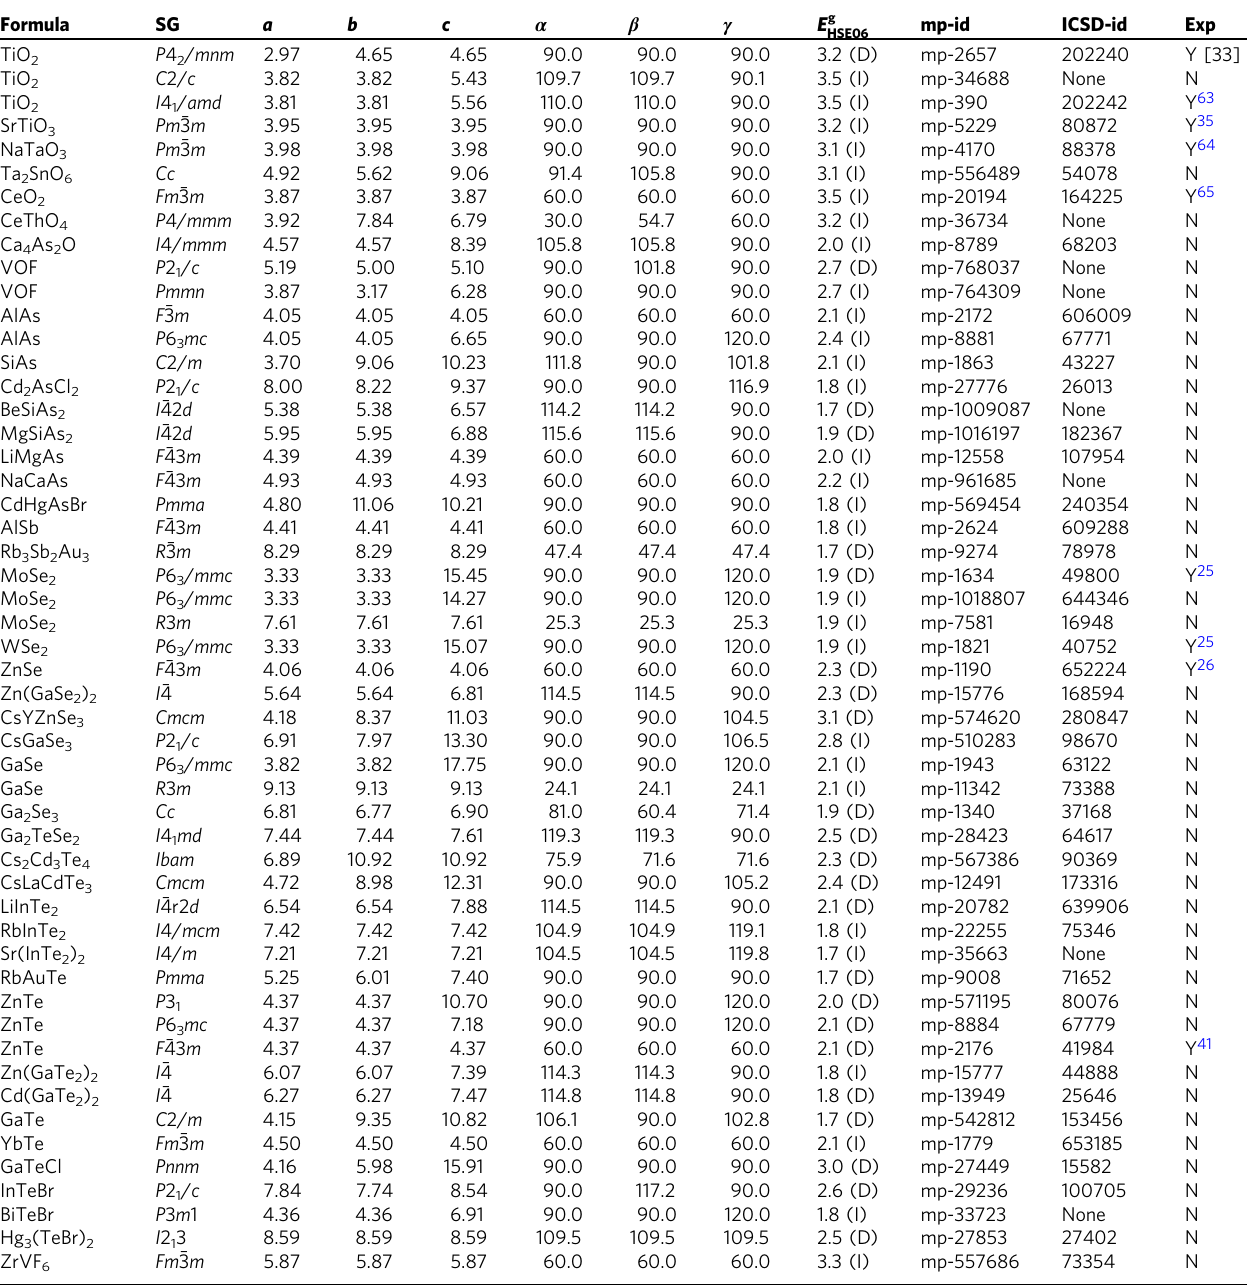
Table 1 The spacegroup (SG), the lattice constants ( a , b , c in Å, α , β , γ in °), bandgaps computed with HSE06 functional ( E g eV), the MP material-id (mp-id) and the ICSD-id for all 52 materials which emerge as suitable photocathodes from the screening are listed in the